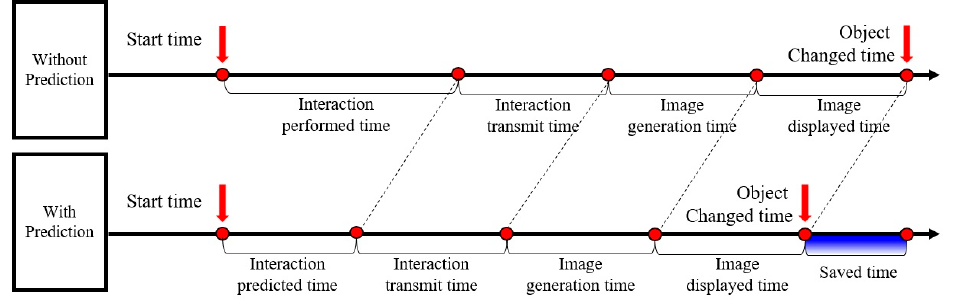
Figure 1. Example of saving time based on predictions.